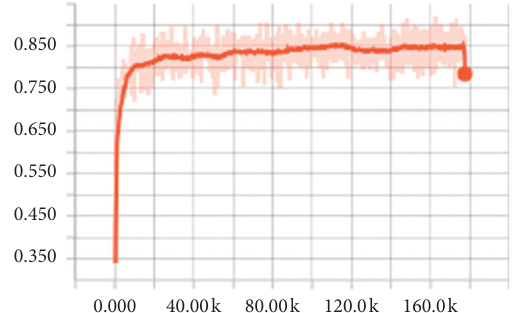
Figure 5: Changes in the accuracy rate of Farmer 2